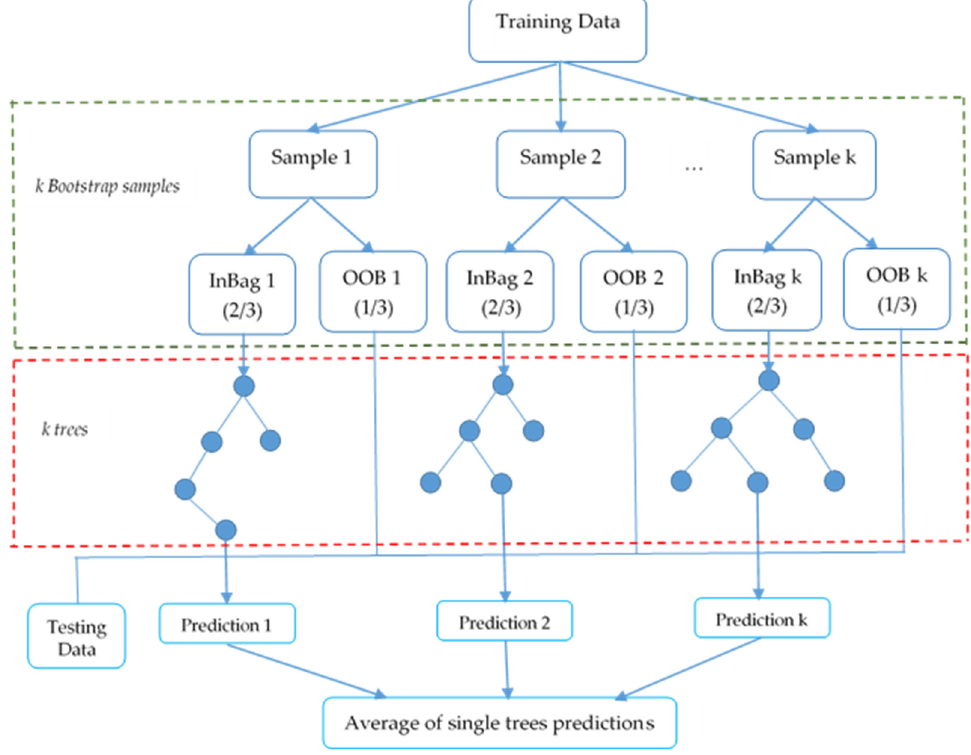
Figure 9. Flowchart of the random forest regression algorithm.